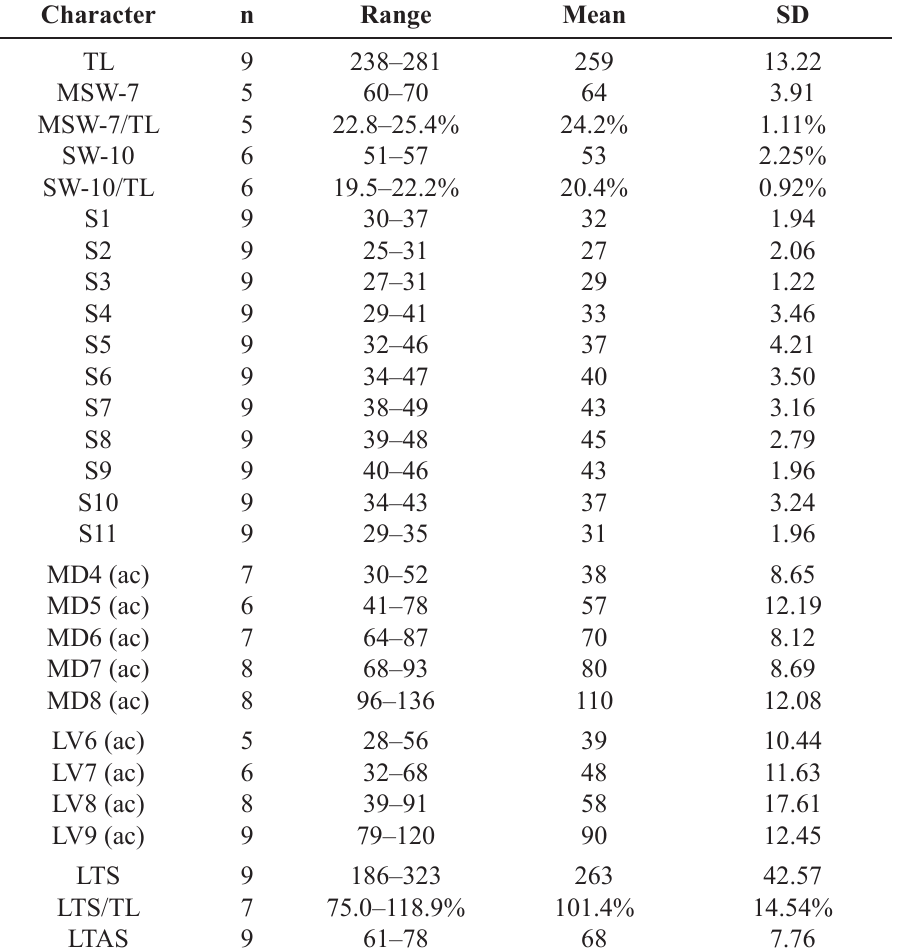
Table 4. Measurements from light microscopy of Echinoderes dubiosus sp. nov. (in µm), including number of measured specimens (n) and standard deviation (SD). Abbreviations: (ac) = acicular spine; LTAS = lateral terminal accessory spine; LTS = lateral terminal spine; LV = lateroventral; MD = middorsal; MSW-7 = maximum sternal width, measured on segment 7 in this species; S = segment lengths; SW-10 = standard width, always measured on segment 10; TL = trunk length.